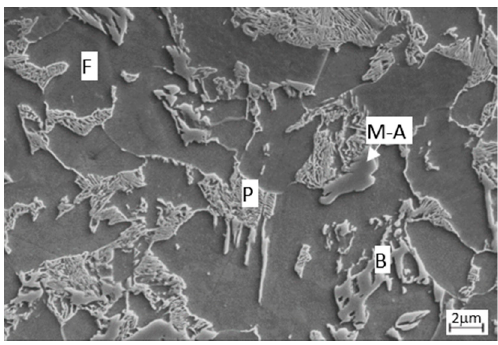
Figure 8. Heat treatment parameters: Soaking 850 °C/100 s, cooling rate 15 °C/s, bainitic hold 400 °C/600 s. Ferritic-pearlitic microstructure with bainite and M-A constituent.